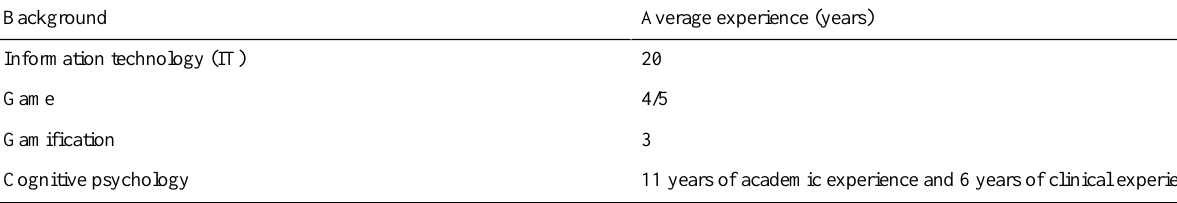
Table 1. Experts’background and average years of